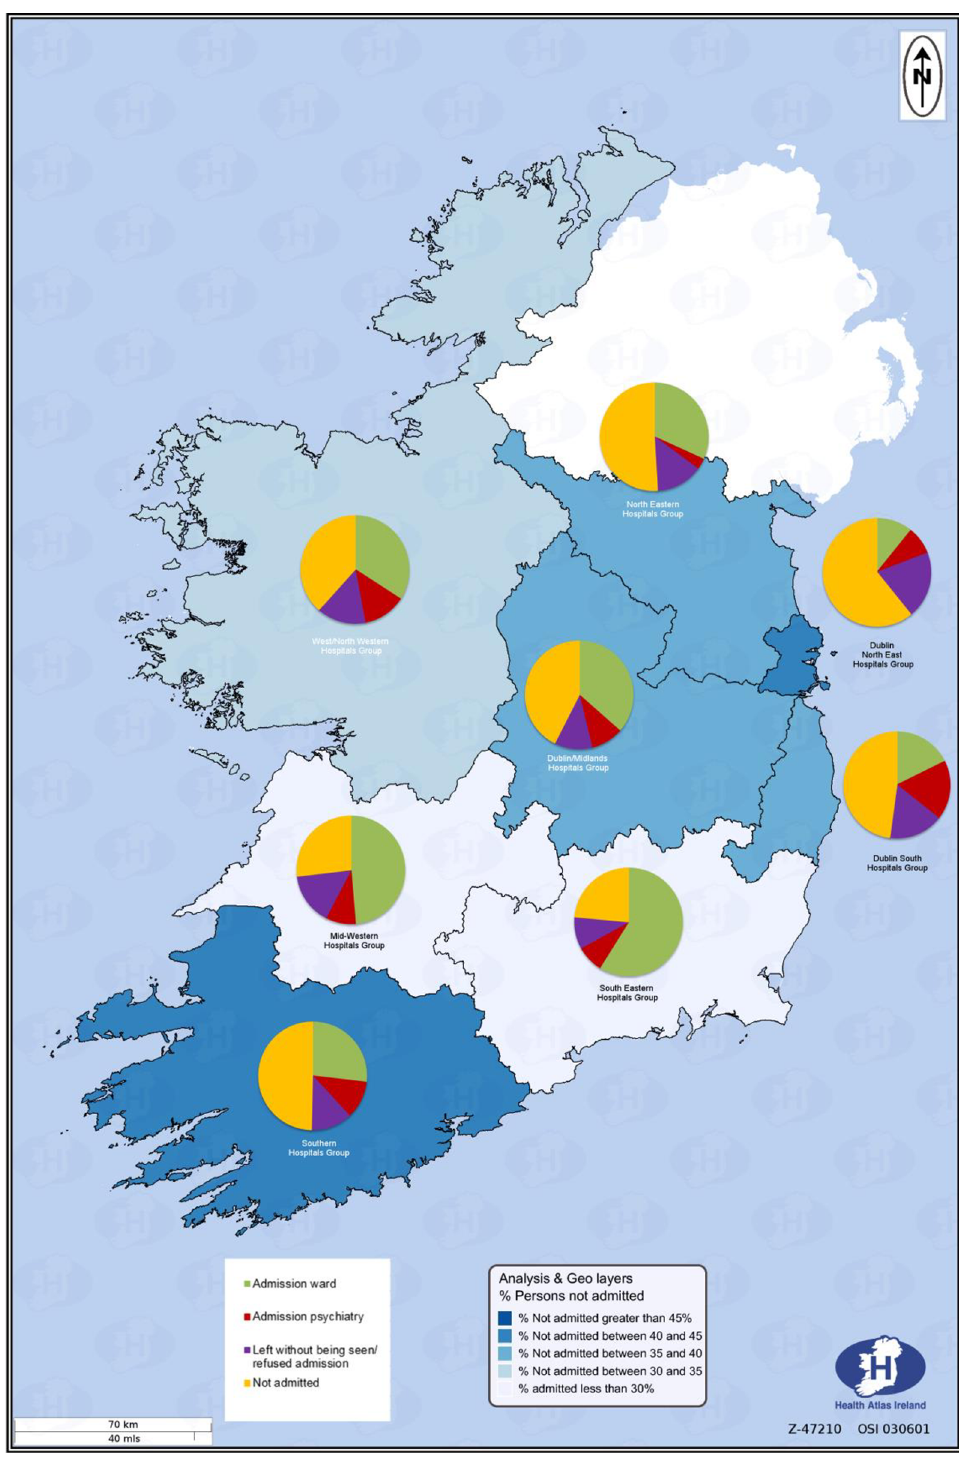
Fig 1. Regional variation of recommended next care of hospital-treated self-harm by HSE Hospital Group, average 2004–2012.